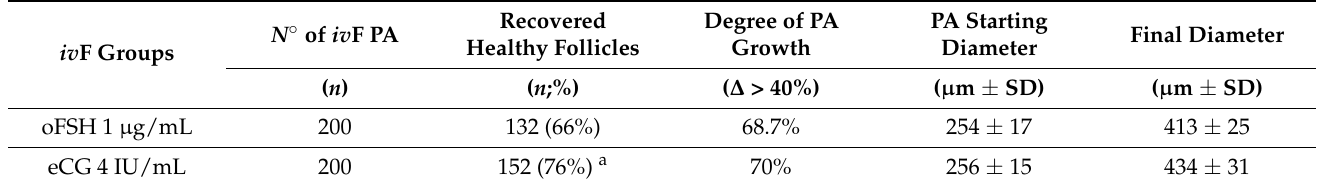
Gonadotropin influence on iv F outcomes: quantitative and qualitative aspects according to follicular treatment groups.